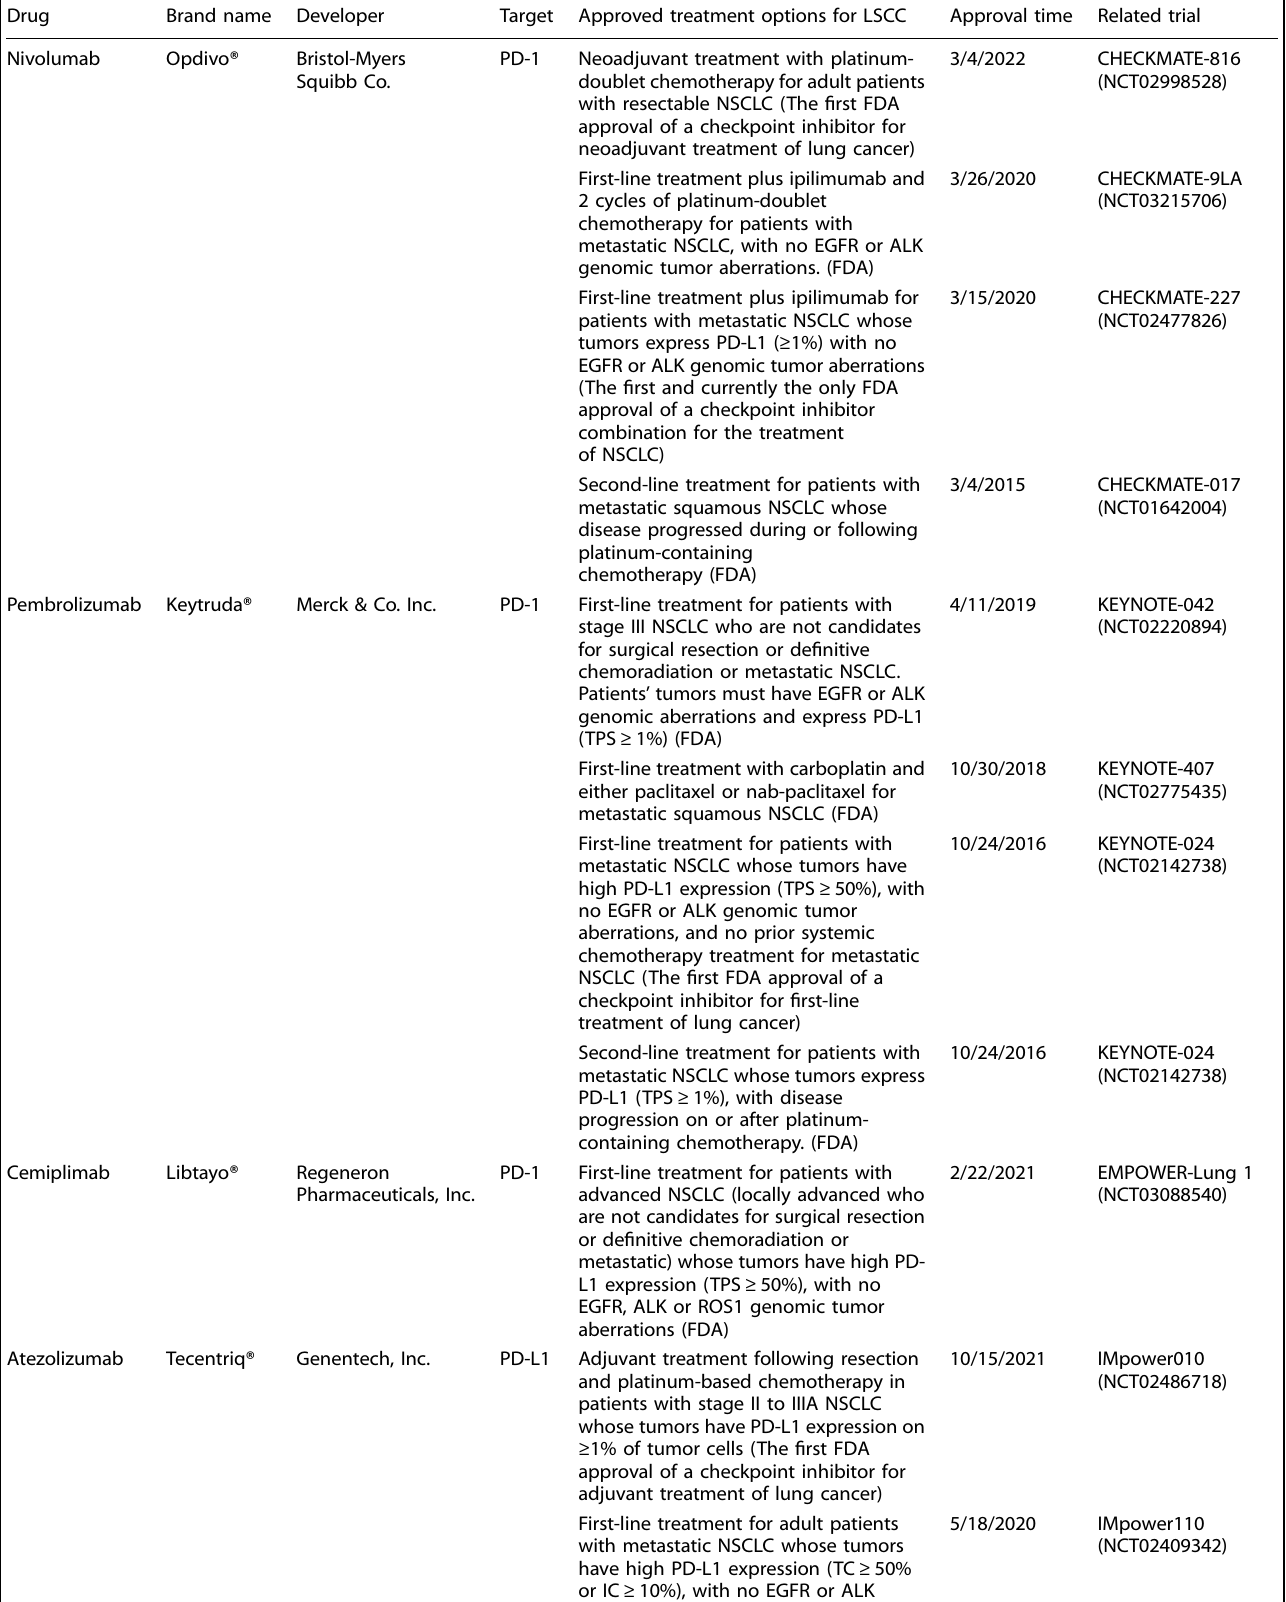
Table 1. ICB therapies approved by FDA or NMPA for the treatment of LSCC